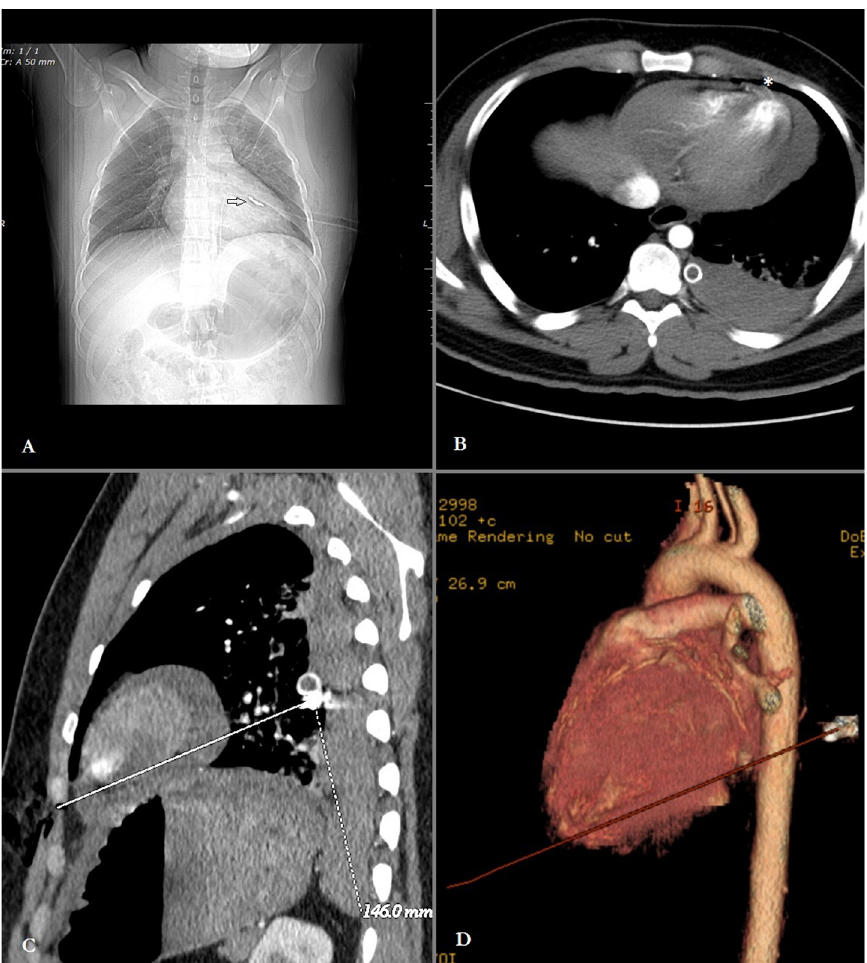
Fig. 1 – A: Fragment lodged in the heart shadow (arrow). B: Myocardial thinning in the ventricular apex (asterisk). C: Trajectory of the fragment, note the possible points of entry and exit in the ventricle. D: Three-dimensional reconstruction of the trajectory and the